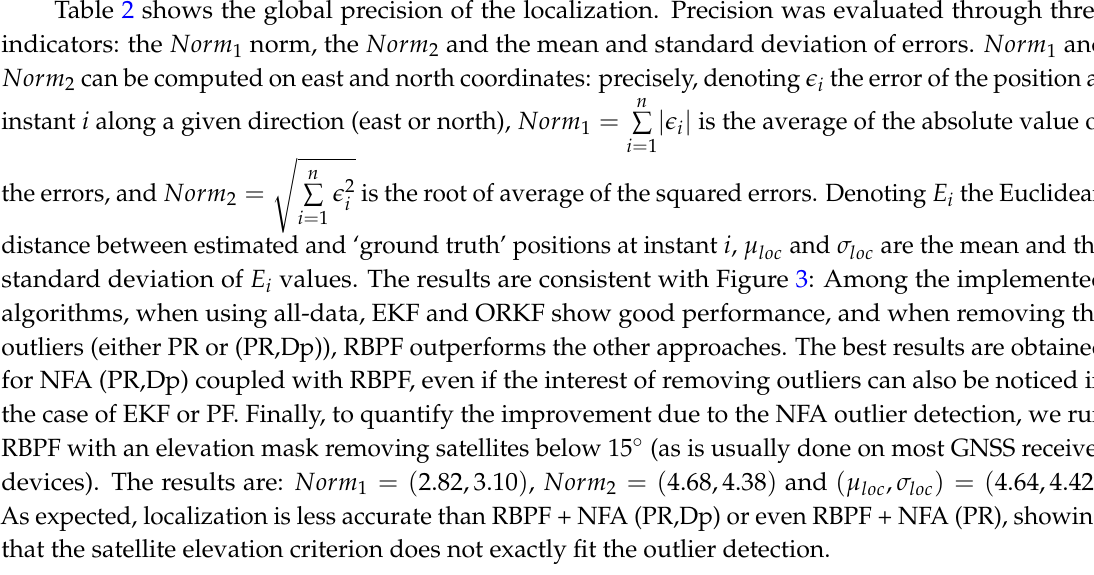
Table 2. Localization error (in m) on (east, north) coordinates, Norm 1 and Norm 2 of error, error mean and standard deviation: comparison of the four versions of KF, the five versions of particle filters and the two GPS solutions on our 11 min 40 s